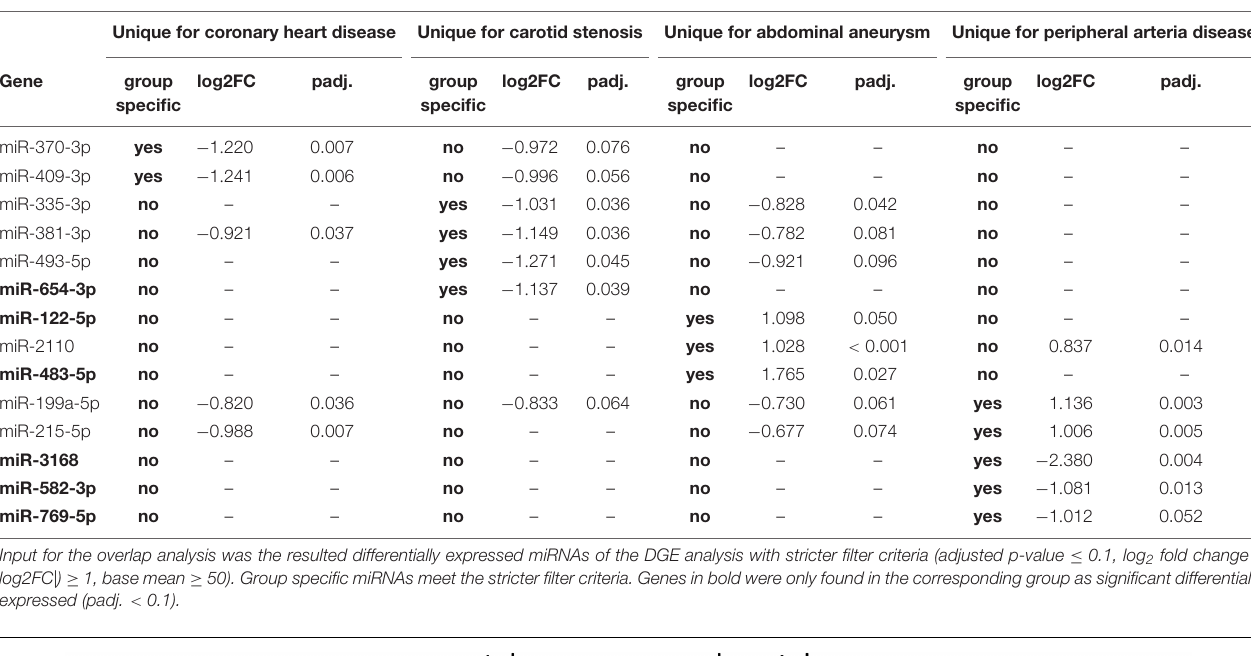
Figure 5 . Figure 5A (PC1 and PC2) represents the comparison of atherosclerotic against control while Figure 5B (PC1 and PC2) displays the comparison of all subgroups and the